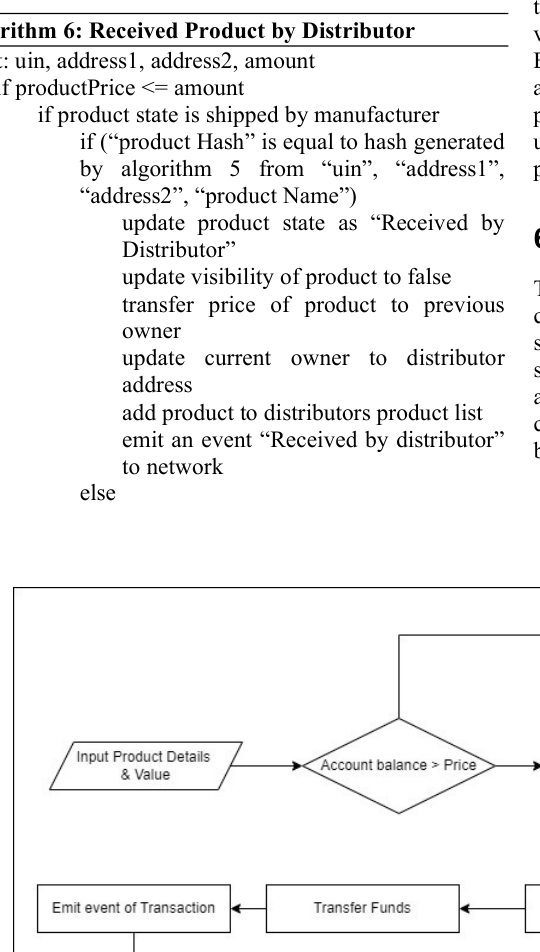
Algorithm 1: Create product by Manufacturer